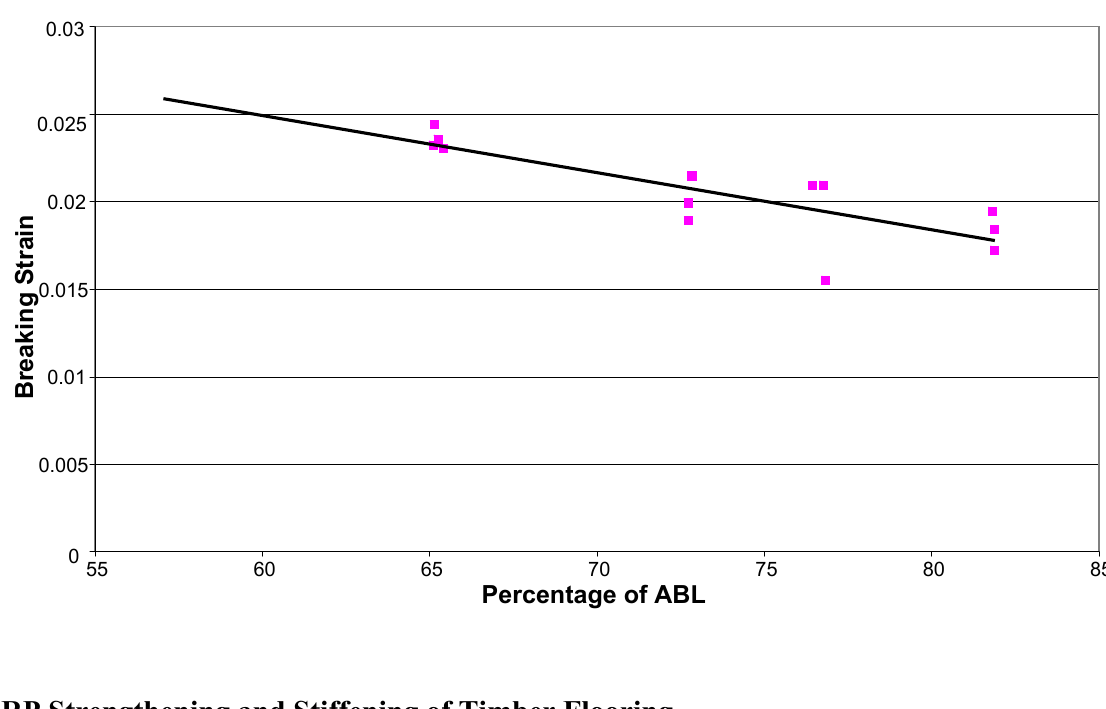
Figure 11. Breaking strain plotted against